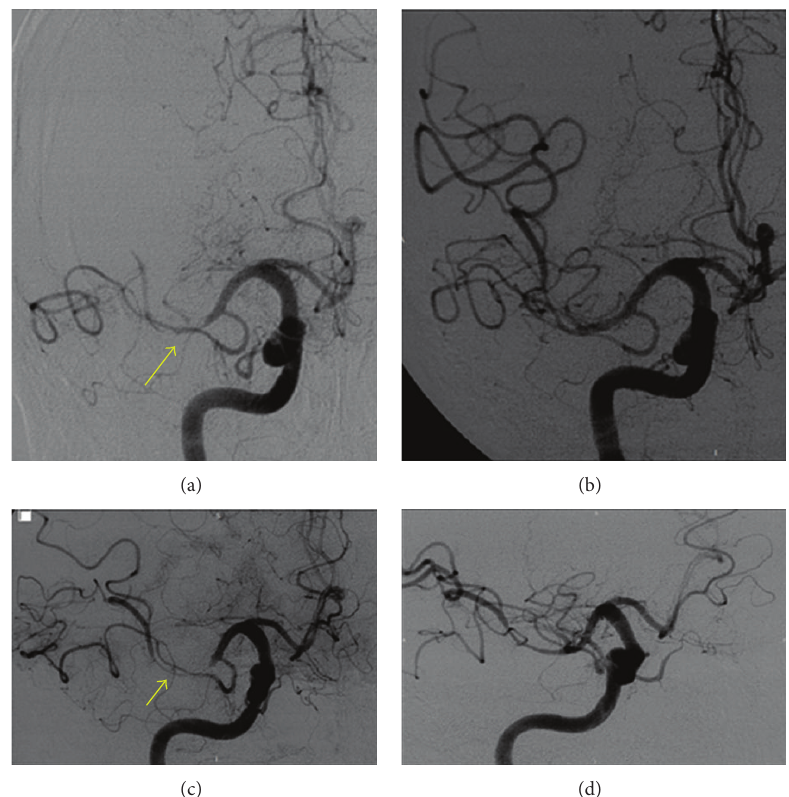
Figure 2: Initial Angiography: anteroposterior view (a) and lateral view (c) evidence complete occlusion of MCA (arrow). Angiography after thrombectomy: anteroposterior view (b) and lateral view (d) show permeable MCA.